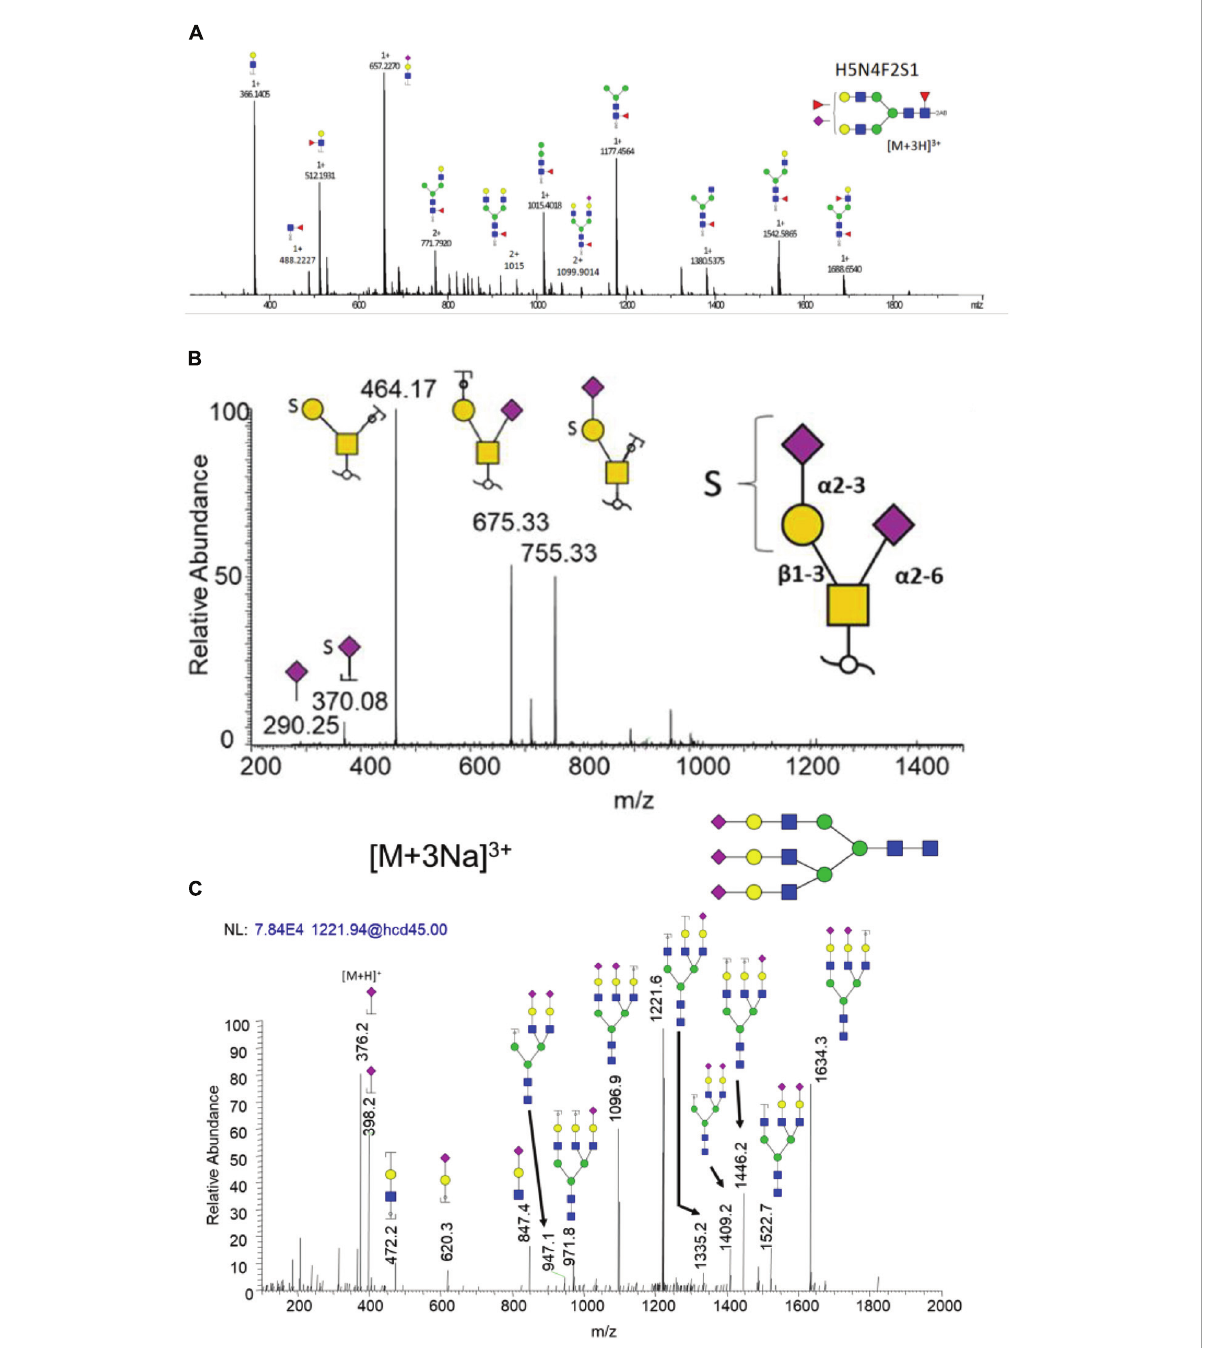
FIGURE6 Examples of common dissociation methods used in CNS diseases. (A) CID of bi-antennary sialylated and fucosylated N-glycan derived from IgG of PD patients. (B) CID of sulfated O-glycan derived from nigrostriatal tissue of PD patients. (C) HCD of tri-antennary tri-sialylated N-glycan derived from neuroblastoma cell line. Reproduced with the modification and permissions of panel (A) from Russell et al. (2017), panel (B) from Wilkinson et al. (2021), and panel (C) from Hu et al. (2015).